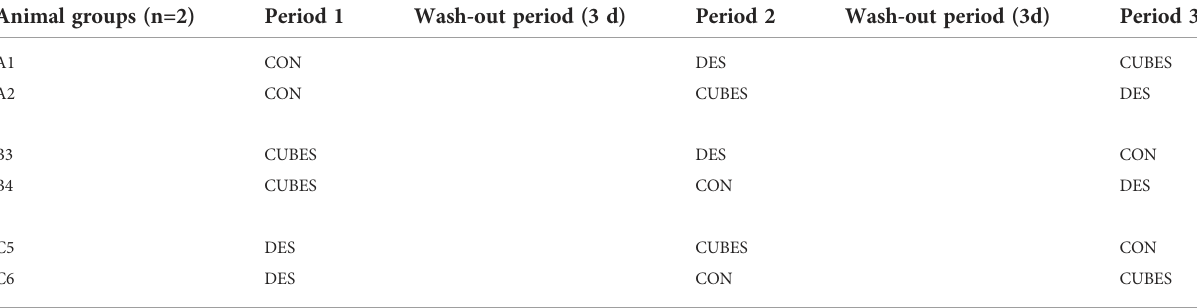
TABLE 1 Animal groups (A, B, and C) allocation to three the dietary treatments (control: CON; control diet plus Desmodium intortum hay: DES and control diet plus dairy cubes: CUBES) over the three experimental periods. Animal groups